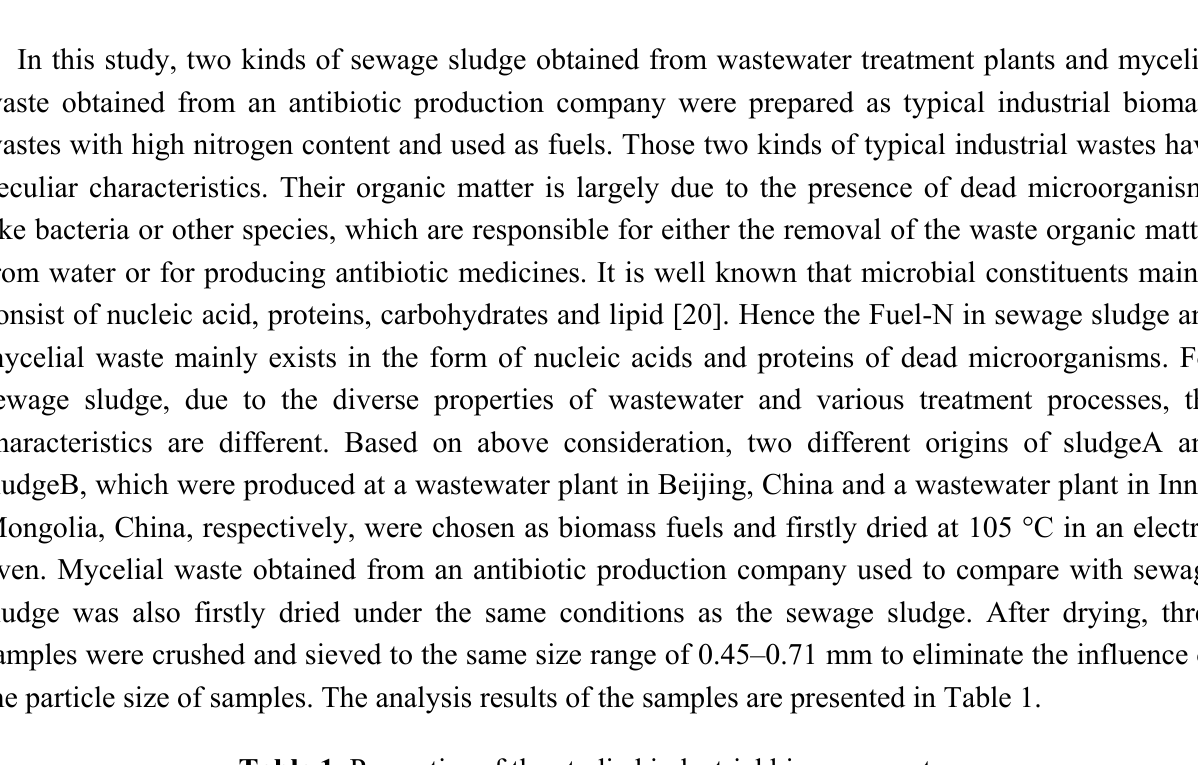
Table 1. Properties of the studied industrial biomass